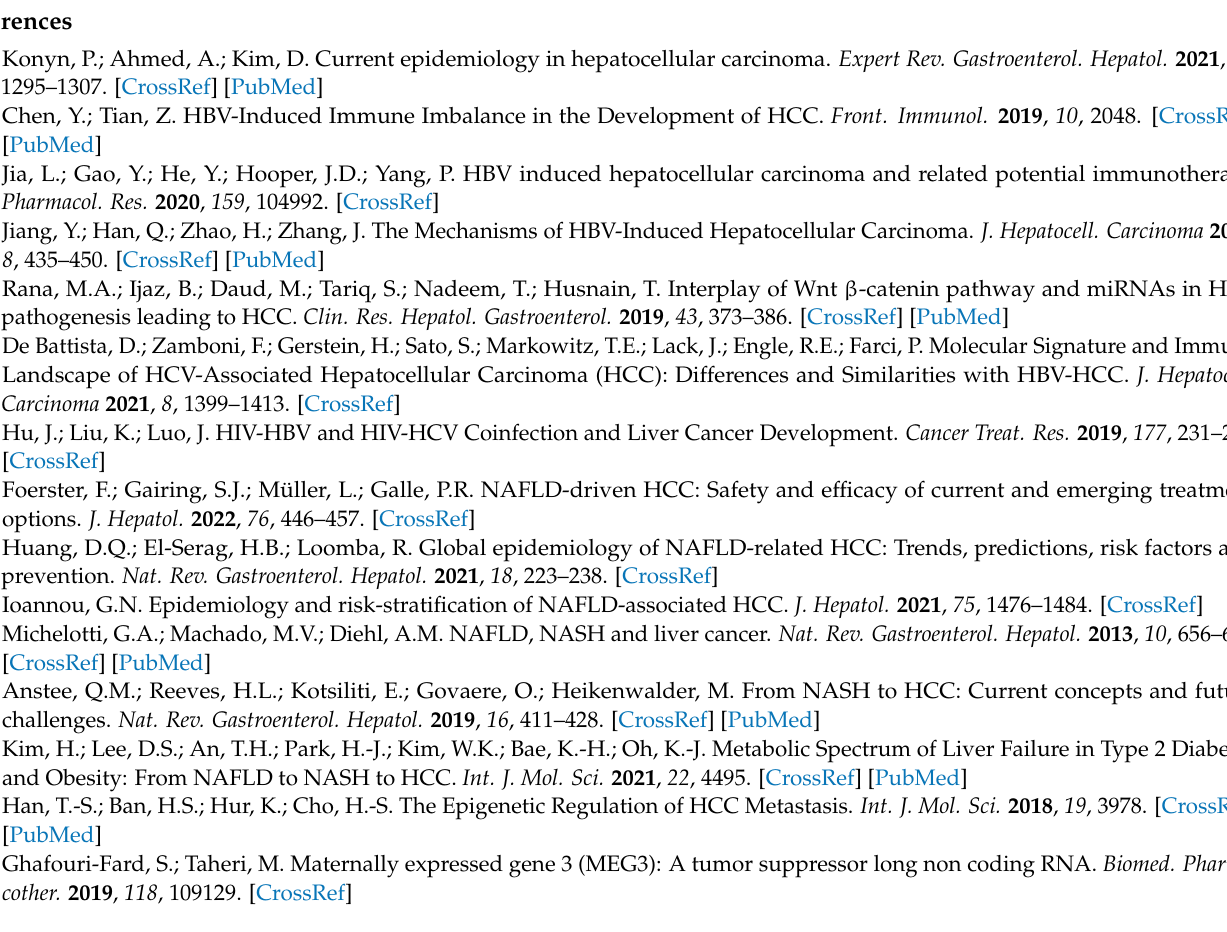
lncRNA interaction; Supplementary Table S2: Energies of individual nucleotides of miR-664a-3p involved in miRNA-lncRNA interaction; Supplementary Table S3: Final MFEs of nucleotides involved in miR-664a-3p-MEG3